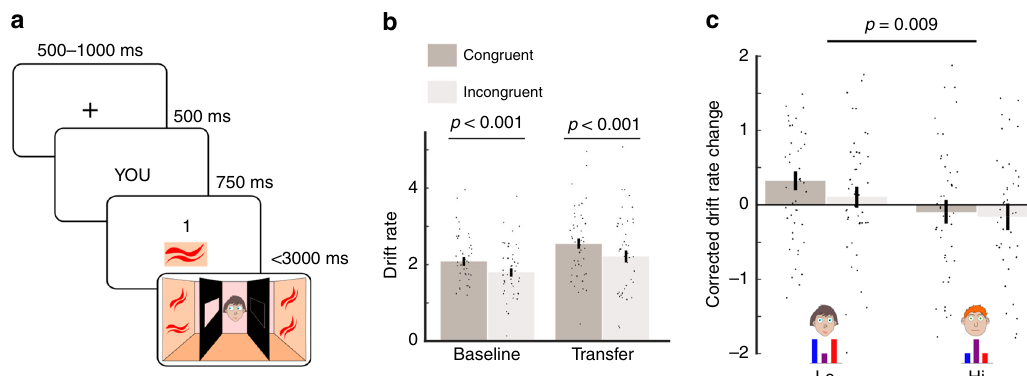
Fig. 3 Behavioural training transfers to a perspective-taking task. a Trial structure of the perspective-taking task. Subjects were fi rst presented with a perspective (Self or Other), followed by a target pattern and number and then a visual scene. Subjects had three seconds to report whether or not the scene contained the target number of target patterns, if adopting the relevant perspective. b Incongruency effect in the perspective-taking task, averaged over Lo-Share and Hi-Share. Mean drift rate parameters were higher on congruent compared to incongruent trials at both baseline and transfer phases. n = 46 independent subjects. Baseline: Paired two-sided t-test: t(45) = 7.6, p < 0.001. Transfer: Paired two-sided t-test: t(45) = 6.7, p < 0.001. c Transfer effect in the perspective-taking task. ‘ Corrected drift rate change ’ (see Methods) was signi fi cantly higher on trials with the Lo-Share agent than trials with the Hi- Share agent. n = 46 independent subjects. Repeated measures ANOVA testing for main effect of avatar: F(1, 45) = 7.4, p = 0.009. Error bars denote s.e.m. Source data are provided as a Source Data fi le.